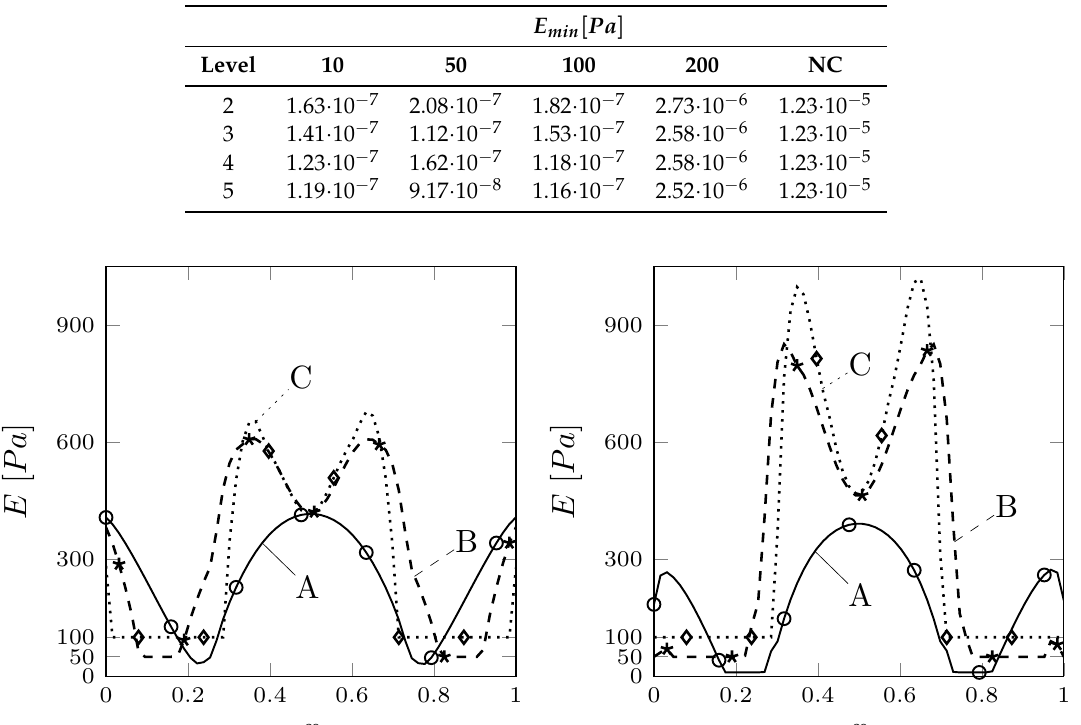
Figure 7. Young modulus profile on the solid vertical mid-line ( left ) and on the interface Γ i ( right ), with different E min = 10 Pa (A), 50 Pa (B), 100 Pa (C). E and E min are scaled by 2.4